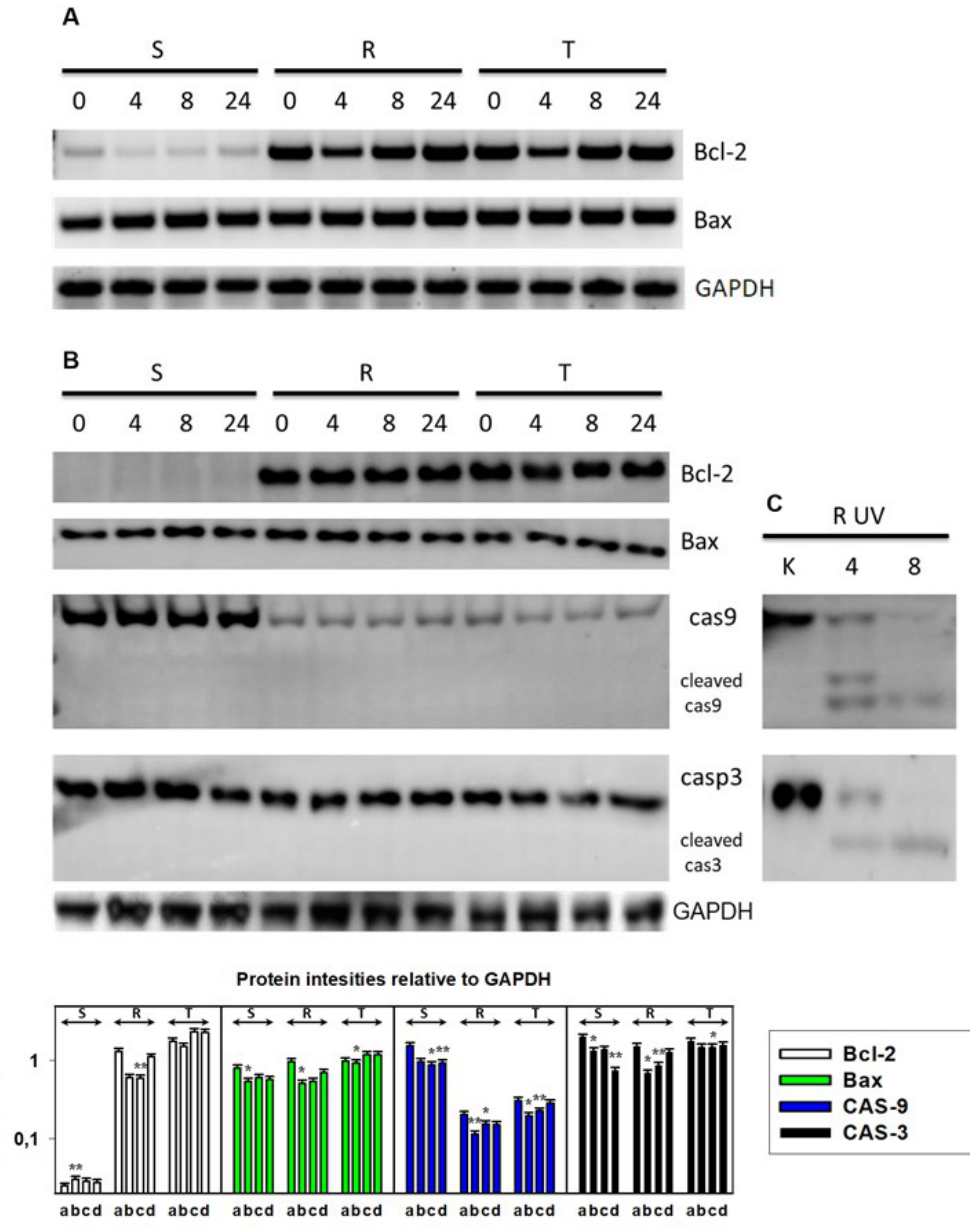
Figure 2. Expression of proteins that are active in apoptosis (Bcl2, Bax, and caspases 3 and 9 and their proteolytically activated forms) in S, R, and T cells after incubation in medium containing 0.1 µM tunicamycin for 0, 4, 8, and 24 h: ( A ) Detection of Bcl2 and Bax transcripts using RT-PCR and detection in agarose gel. ( B ) Western blot detection of Bcl2, Bax, and caspases 3 and 9: GAPDH was used as an internal control. Densitometry quantification of protein bands from Western blots (column plot expressed as the mean ± S.E.M. of three independent measurements of data relative to the GAPDH signal). Cells were incubated in the presence of 0.1 µM tunicamycin for 0 (a), 4 (b), 8 (c), and 24 (d). Significance: Data differ from values obtained in cells that were not incubated in the presence of tunicamycin (a) at the levels: * p < 0.02; ** p < 0.002. ( C ) Activated, proteolytically cleaved caspase 9 (upper) and caspase 3 (lower) as a control for caspase activation in R cells after 10 min of UV irradiation using a germicide lamp: After irradiation, the cells were incubated for 4 and 8 h in culture medium. Similar proteolytically cleaved forms of caspases after UV irradiation were also detected in S and T cells (not shown).